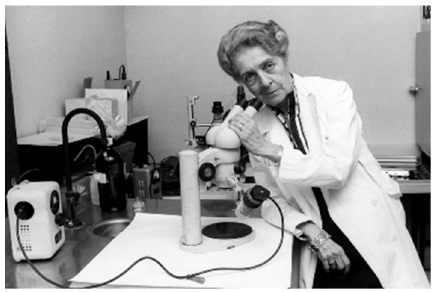
Figure 2. Rita Levi Montalcini (Nobel Prize in 1986 for Nerve Growth Factor discovery).